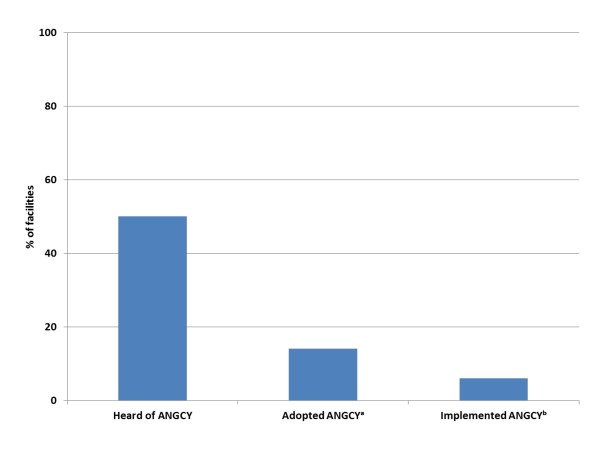
Proportion of recreational facilities that were aware of, and had adopted and implemented the ANGCY (n = 151). aAdoption is defined as facilities in stages 3-5 of the transtheoretical model (preparation, action, maintenance) [29]. bImplementation is defined as facilities in stages 3-5 of the transtheoretical model that had made ANGCY-motivated changes to improve nutritional quality. ANGCY, Alberta Nutrition Guidelines for Children and Youth.